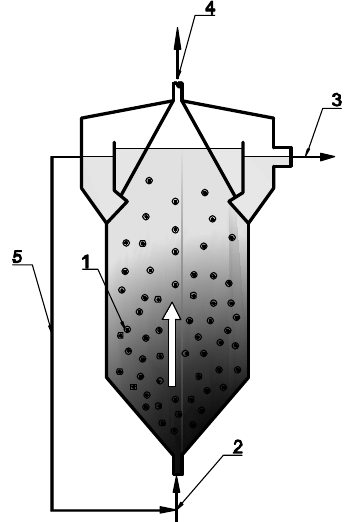
Figure 7. Fluidized-bed reactor diagram: 1—fluidized bed, 2—raw wastewater, 3—treated effluent, Figure 7. Fluidized ‐ bed reactor diagram: 1—fluidized bed, 2—raw wastewater, 3—treated effluent,